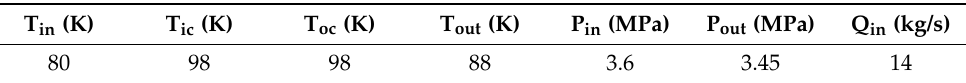
Table 6. Bearing motion boundary condition and power loss for one ball.